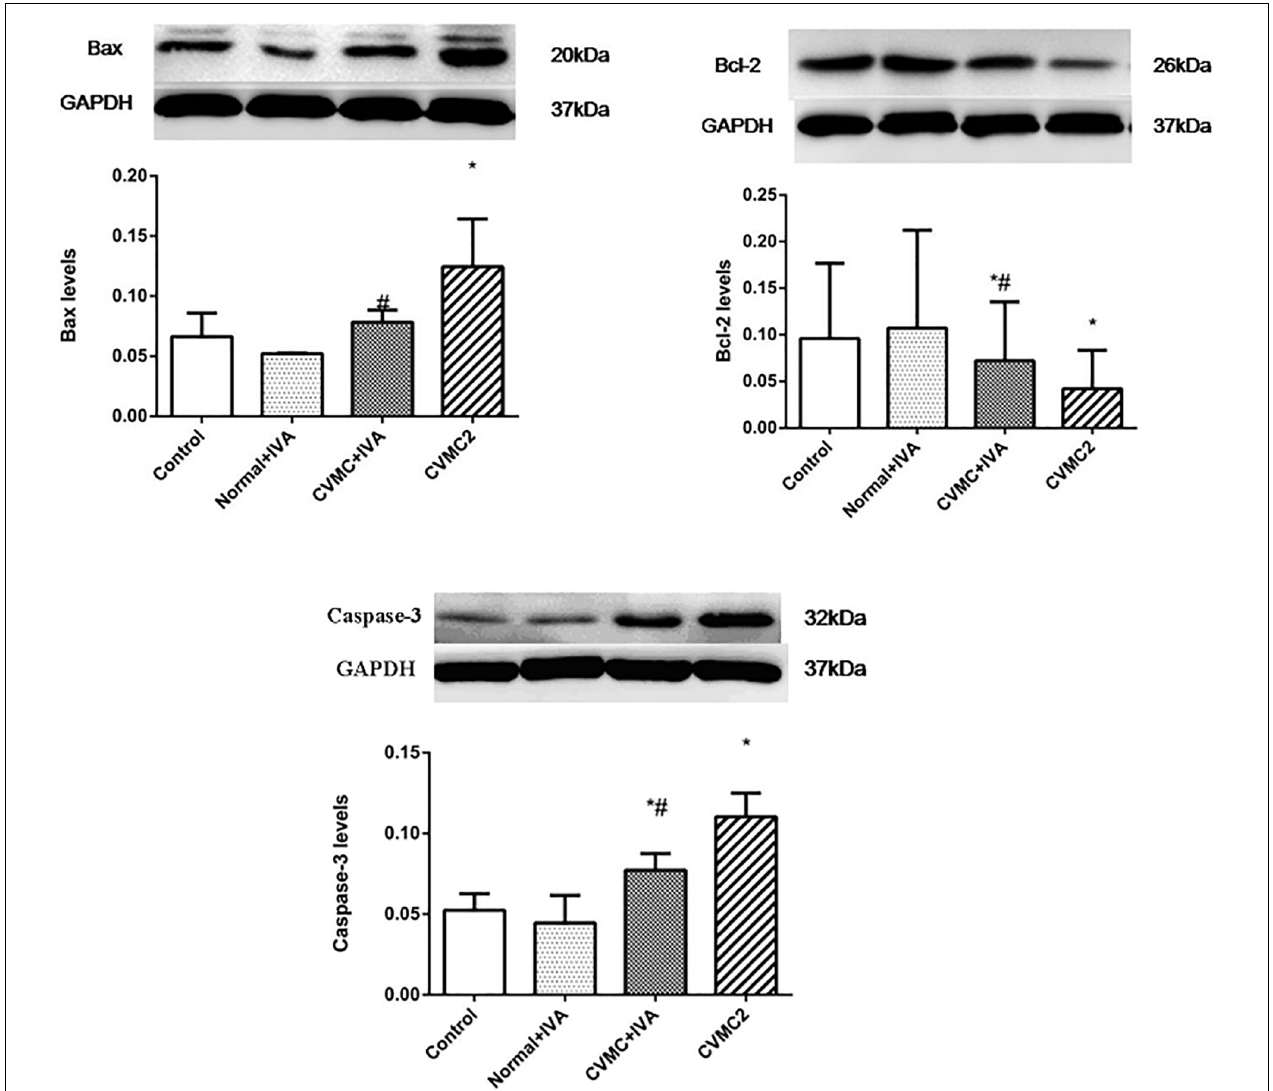
FIGURE 8 | WB analysis for Bax, Bcl-2, and Caspase-3 in each groups ( n = 8). Treatment with ivabradine (IVA) significantly reduced the expression levels of Bax and Caspase-3, and increased the expression level of Bcl-2. ∗ P < 0.05 vs. Control (Normal control 2 group), # P < 0.05 vs. CVMC2.